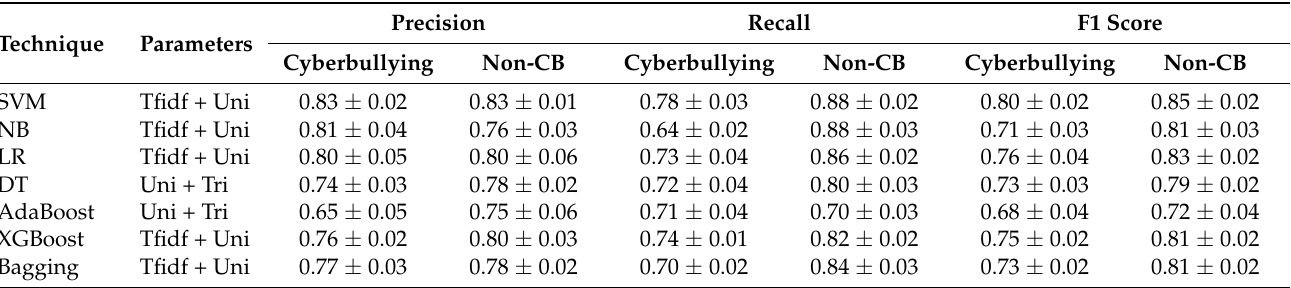
Table 6. Performance evaluation of proposed models based on precision, recall, and F1